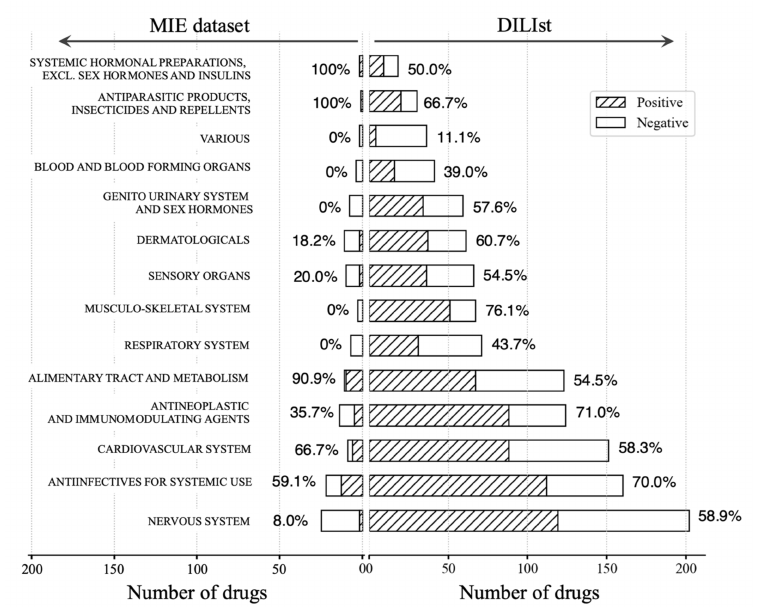
Figure 5. ATC distribution of LMT-inducing drugs and comparison with the DILIst dataset. Com- parison of DILI-negative (white bars) and DILI-positive drugs (hatching bars) between the MIE and DILIst dataset at the anatomical group level. Percentages depict the ratio of positive drugs in each anatomical